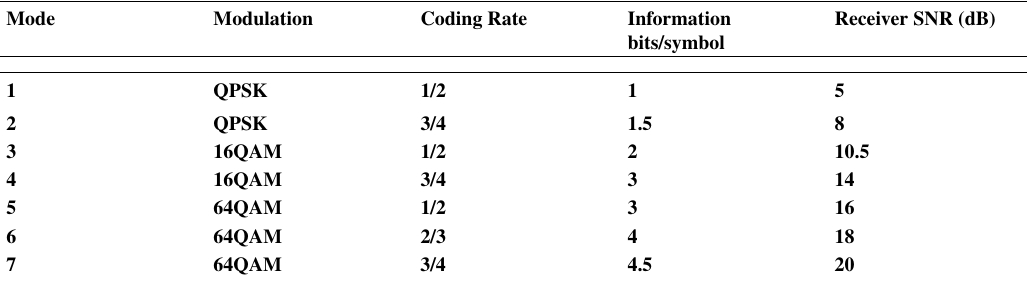
Table 4. IEEE 802.16 OFDMA PHY Modulation and Coding Schemes